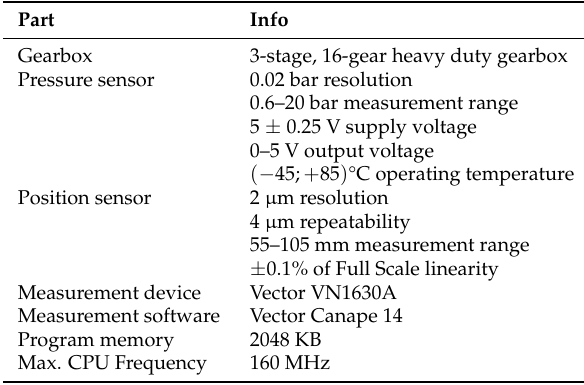
Table 2. Measurement configuration.